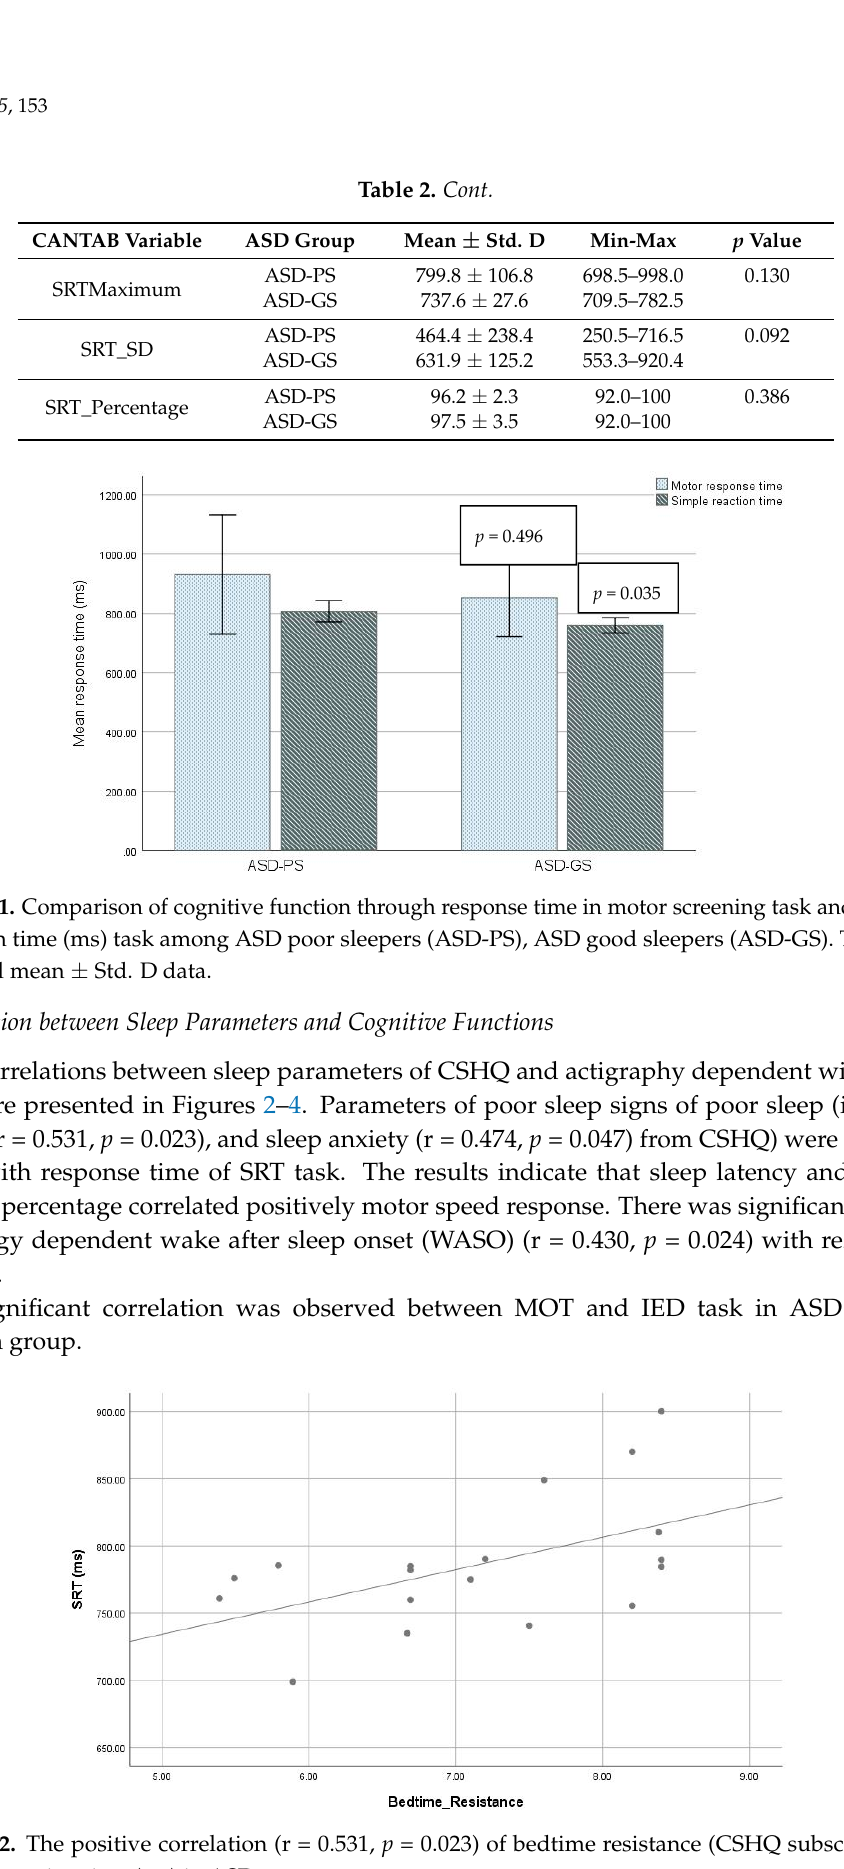
Figure 3. Correlation (r = 0.474, p = 0.047) of sleep anxiety (CSHQ subscale) and simple reaction time (ms) in ASD.